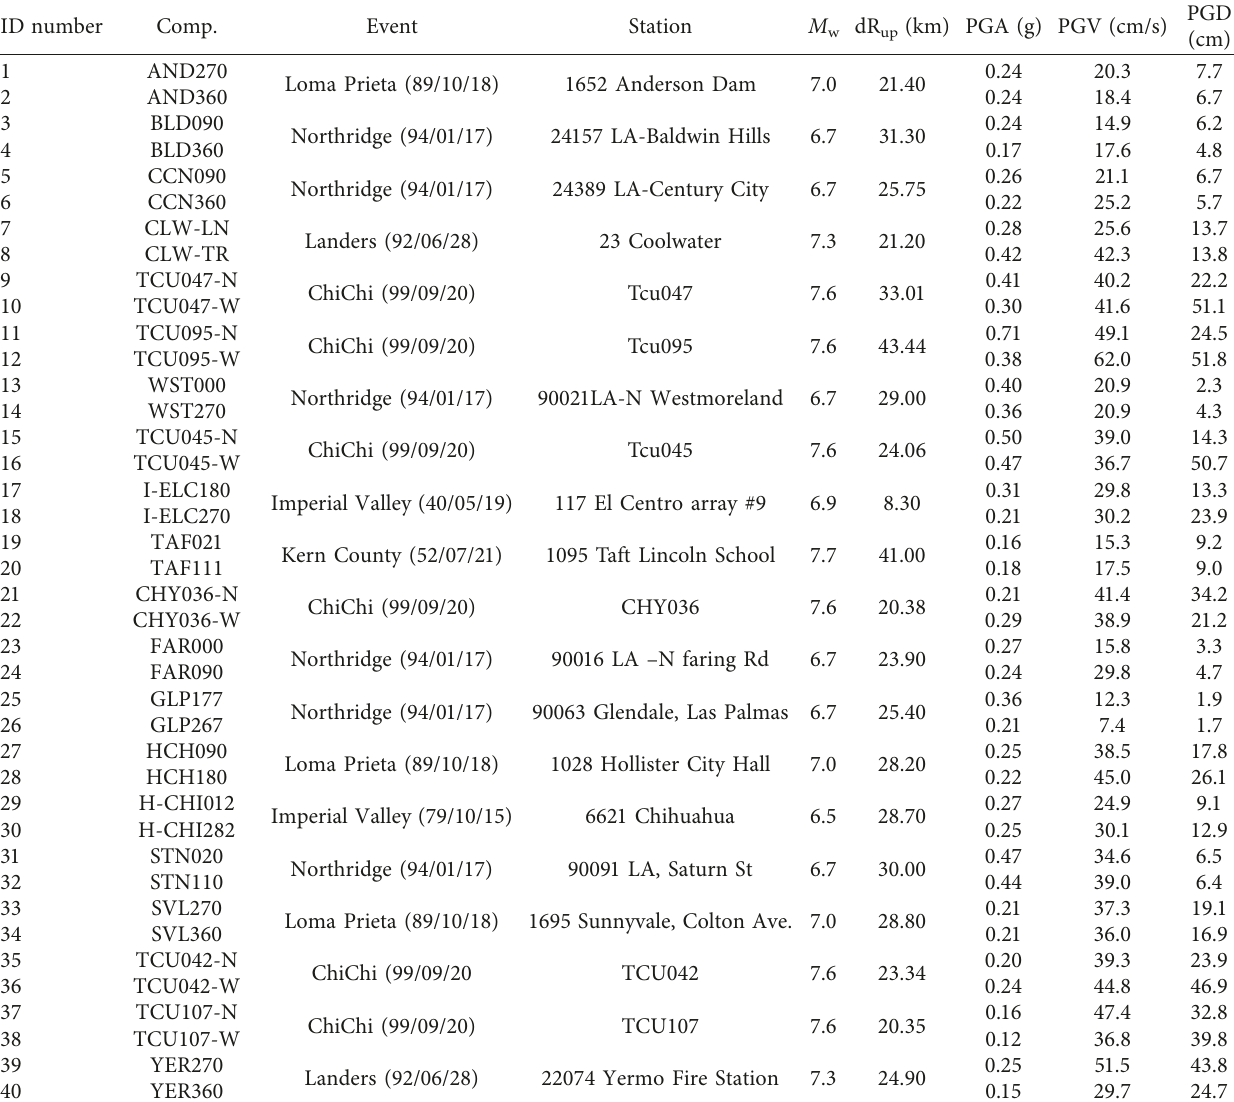
Table 2: 20 stations with two-component ground